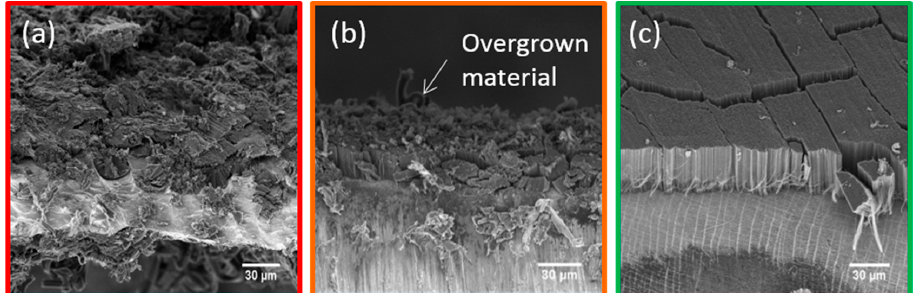
Figure 1. Scanning electron microscope (SEM) images of carbon nanotube (CNT) synthetized at 580 ◦ C on thin aluminium (Al) discs during 20 min with: ( a ) high Fe / C ratio ( > 4 wt.%) and ( b ) medium Fe / C ratio (between 2 and 4 wt.%) and ( c ) low Fe / C ratio ( < 2